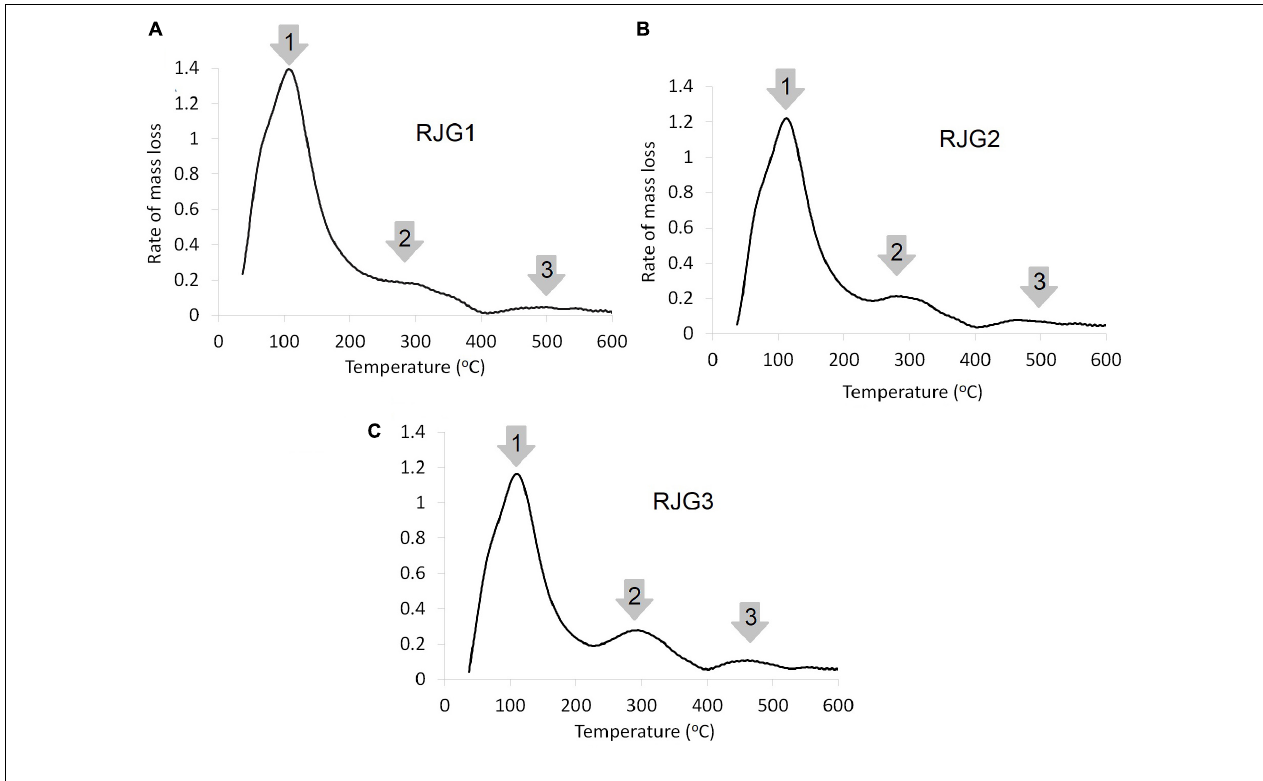
FIGURE 10 | TGA analysis of recycled jute-based composites RJG1 (A) , RJG2 (B) , and RJG3 (C) .